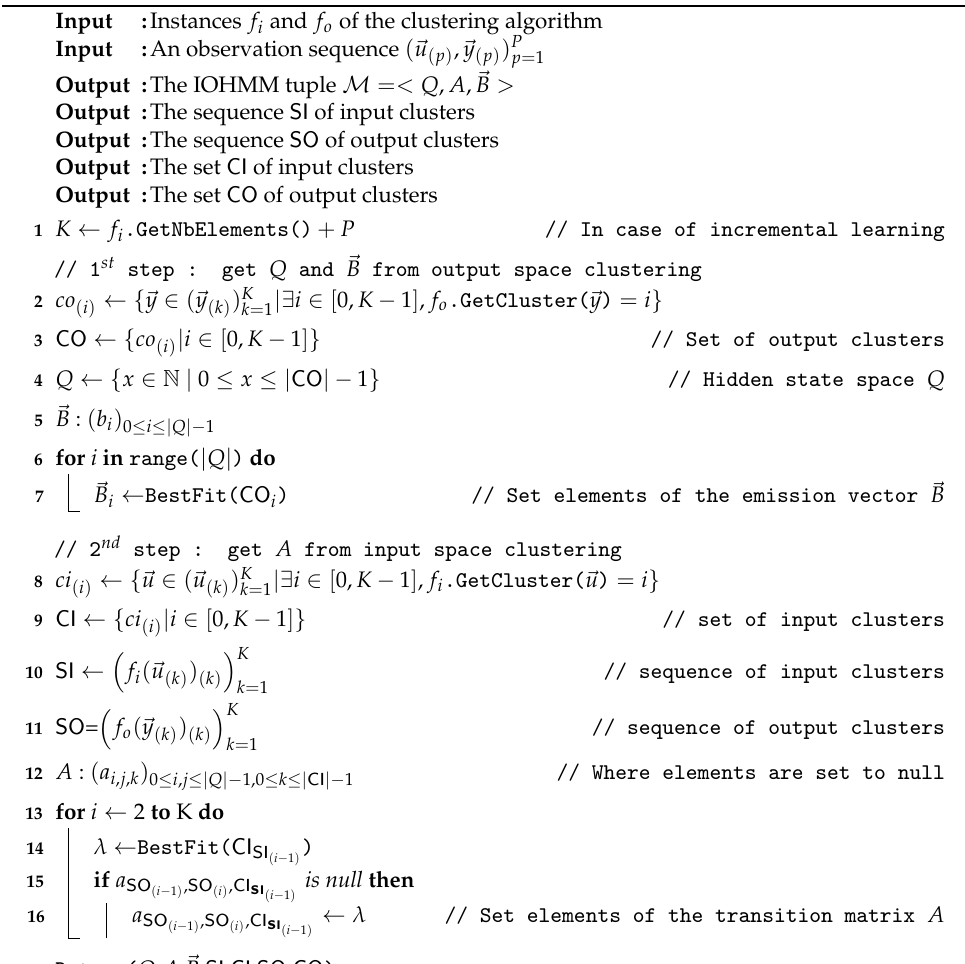
Algorithm 1: Learning of IOHMM structure Φ and parameters λ